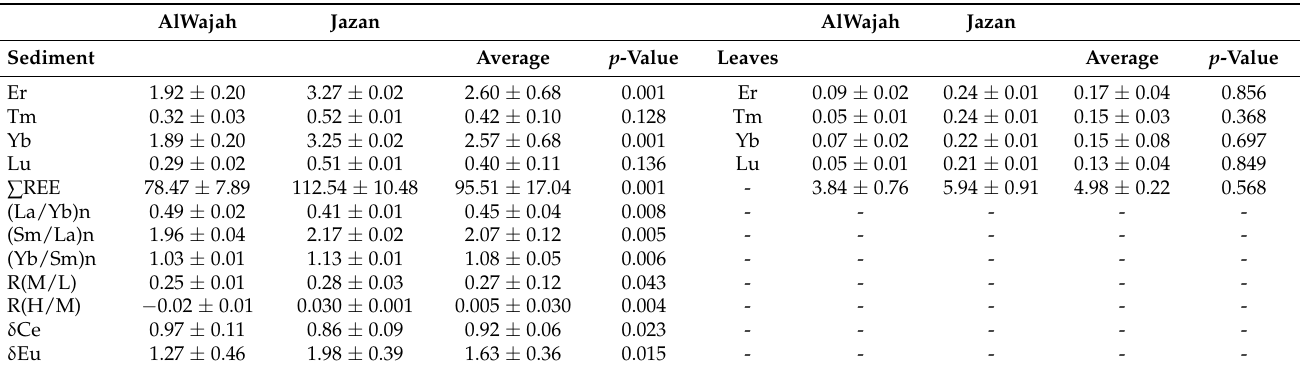
Figure 1. Principal component analysis biplot ( A ) and loadings ( B ) for the relationship between rare earth elements in AlWajah and Jazan mangrove ecosystems. G—Gravel, CSTP—Clay and Silt par- ticles, CS—Coarse sandy. 2.2. Fractionation of REE and Sediment Quality Index The Post-Archean Australian Shale (PASS) (Taylor and McLennan, 1985) normalized REE patterns of the sediments for the two mangrove ecosystems plotted provide a better understanding of the pattern of accumulation of REE in this study (Figure 2). The results reveal ∑ REE relative enrichment and comparative trends of fractionation for REE. The fraction (La/Yb)n was higher (0.49) in the Al Wajah mangrove than the Jazan mangrove (0.41), with an average of 0.45 ± 0.04 for the two mangroves (Table 1). For the fractions using (Sm/La)n, a significantly higher value (2.17) was revealed at Jazan, while the lowest value was recorded in Al Wajah sediment samples. The average value for the (Sm/La)n fraction was 2.07, which is the highest median proportion when compared to other frac- tions, revealing a significant LREE and MREE accumulation (Figure 2; Table 1). The Al Wajah mangrove had the lowest value (1.03) of (Yb/Sm)n, while a significantly higher value (1.13) was recorded for sediment sampled from the Jazan mangrove ecosystem. The average for (Yb/Sm)n in the two mangrove ecosystems was 1.08.